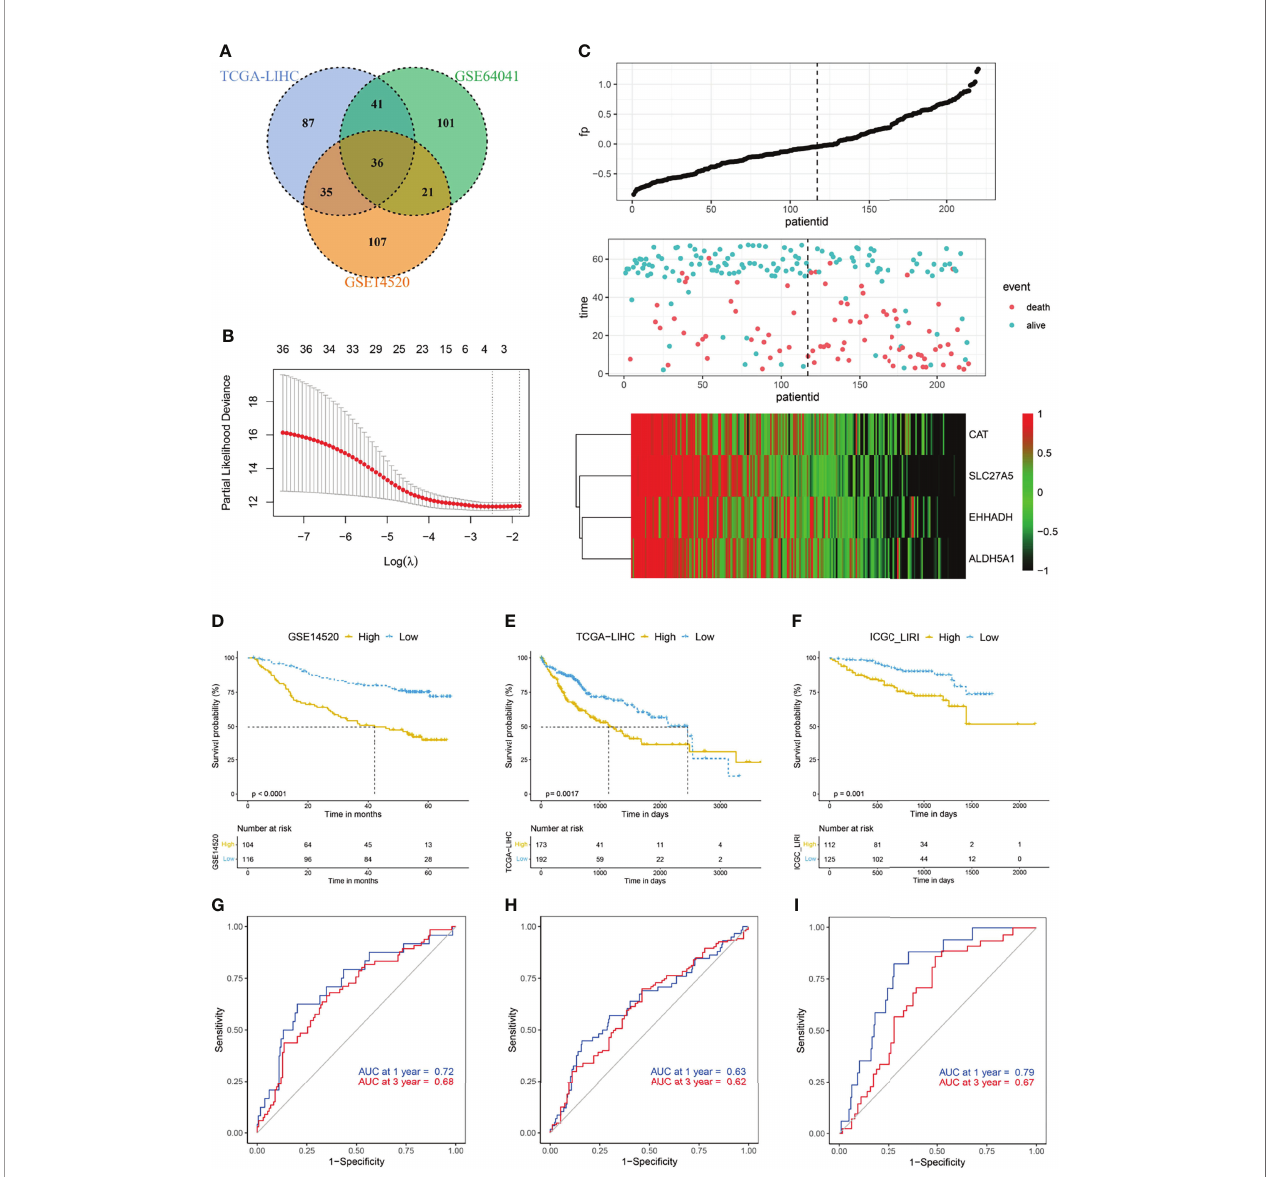
FIGURE 2 | Construction of cuproptosis-related risk score (CRRS). (A) Venn diagram indicating the 36 FDX1 -related genes identi fi ed in all three cohorts. (B) The LASSO Cox regression model was constructed from FDX1 and its related genes. The tuning parameter ( l ) was calculated based on the partial likelihood deviance with 10-fold cross validation. An optimal log l value shown by the vertical black dot-lines in the plots. The four signature genes were identi fi ed according to the best fi t pro fi le. (C) The distribution and optimal cutoff value of CRRS, the OS status of each sample, and the expression value of the four crucial genes in the GSE14520 dataset. (D – F) The prognostic signi fi cance of CRRS in GSE14520 (D) , TCGA-LIHC (E) , and ICGC-LIRI (F) cohorts. About 47.3% (104/220) of the HCC patients in the GSE14520 were divided into high-CRRS subgroup and the remaining patients were in the low-CRRS subgroup based on the optimal cutoff value of the CRRS. In the validating datasets (TCGA-LIHC and ICGC_LIRI), 47.3% of HCC patients were also classi fi ed into the high-CRRS subgroup according to the value of CRRS. The Kaplan – Meier method was used for prognosis analysis. (G – I) Time-dependent ROC analyses of the CRRS regarding the OS and survival status in the GSE14520 (G) , TCGA-LIHC (H) , and ICGC-LIRI (I)